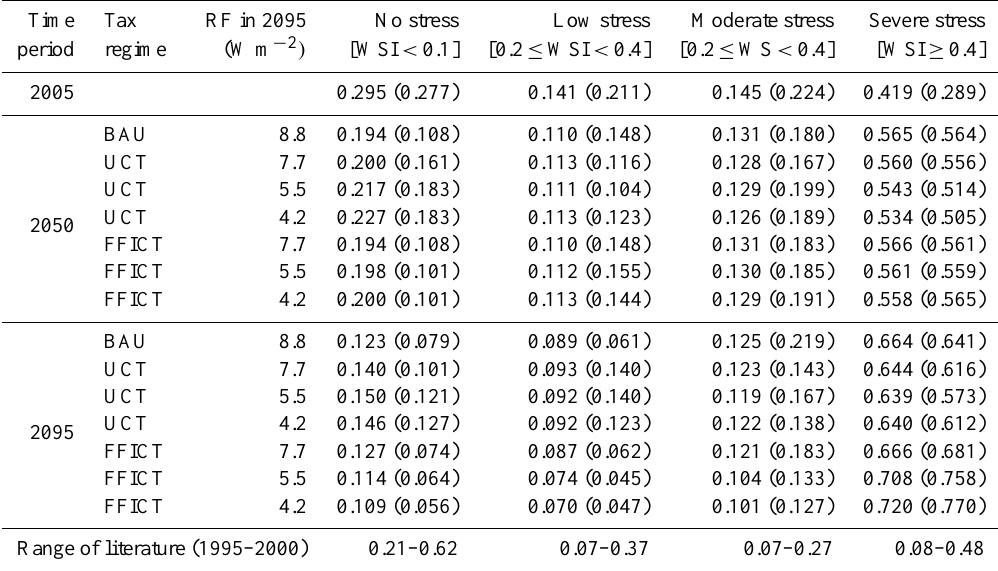
Table 4. Fraction of global population living under each water scarcity category, and under different climate mitigation policies and tax regimes; scarcity is calculated at the grid scale (basin